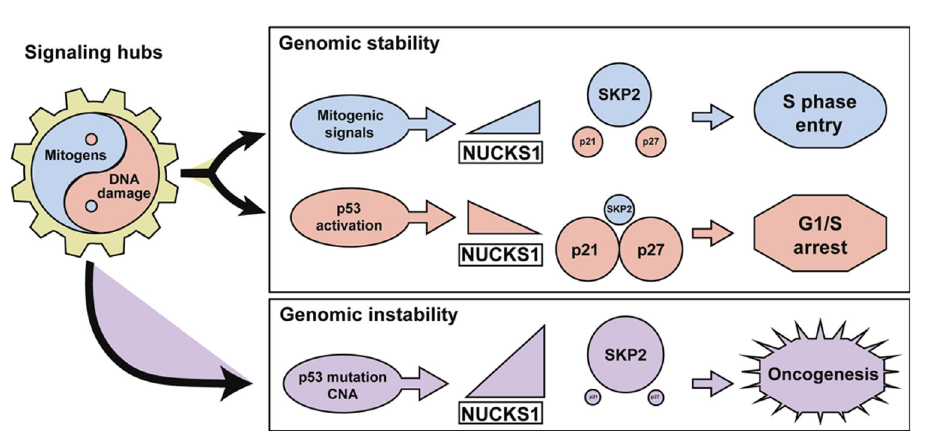
Fig. 7 Model depicting the role for NUCKS1 in the S phase entry decision. The NUCKS1-SKP2-p21/p27 axis constitutes a signalling hub which integrates the opposing cell cycle signals, mitogens and DNA damage. Mitogens stimulate binding of NUCKS1 to the SKP2 promoter, SKP2 expression, p21/p27 degradation, and S phase entry. DNA damage induces p53-dependent repression of NUCKS1 , leading to SKP2 ’ s transcriptional downregulation, upregulation of p21/p27, and cell cycle arrest. Some cancer cells increase NUCKS1/SKP2 copy number and mutate p53, leading to NUCKS1 and SKP2